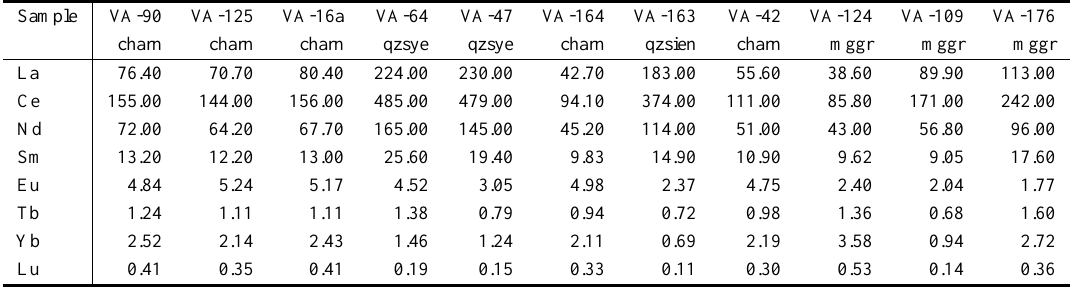
(mggr) from Várzea